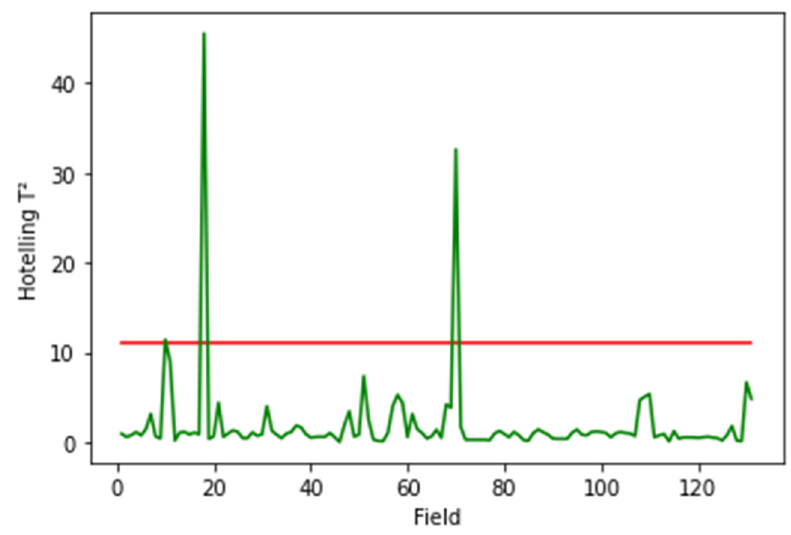
Figure 9. The Hotelling T 2 chart for miscible CO 2 -EOR simultaneous screening model A. Table 3. Summary of the miscible CO 2 -EOR screening model. Screening Model